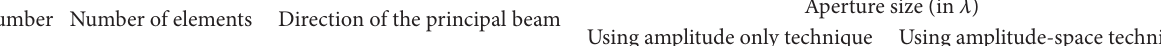
Table 3: Aperture size